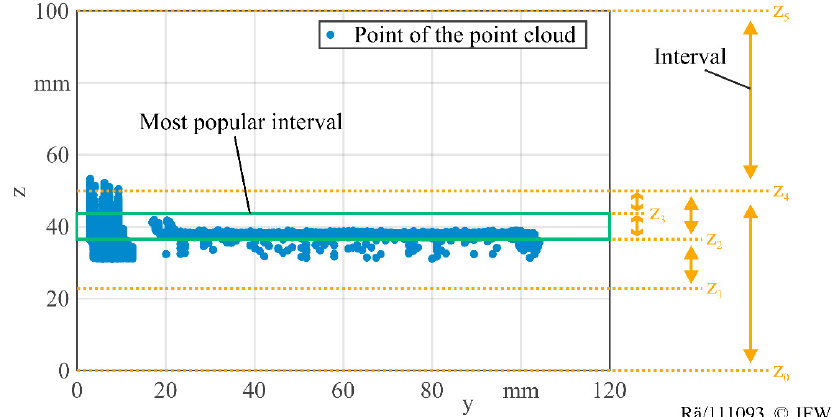
Figure 7. The principle of the z-interval decomposition of a point cloud.